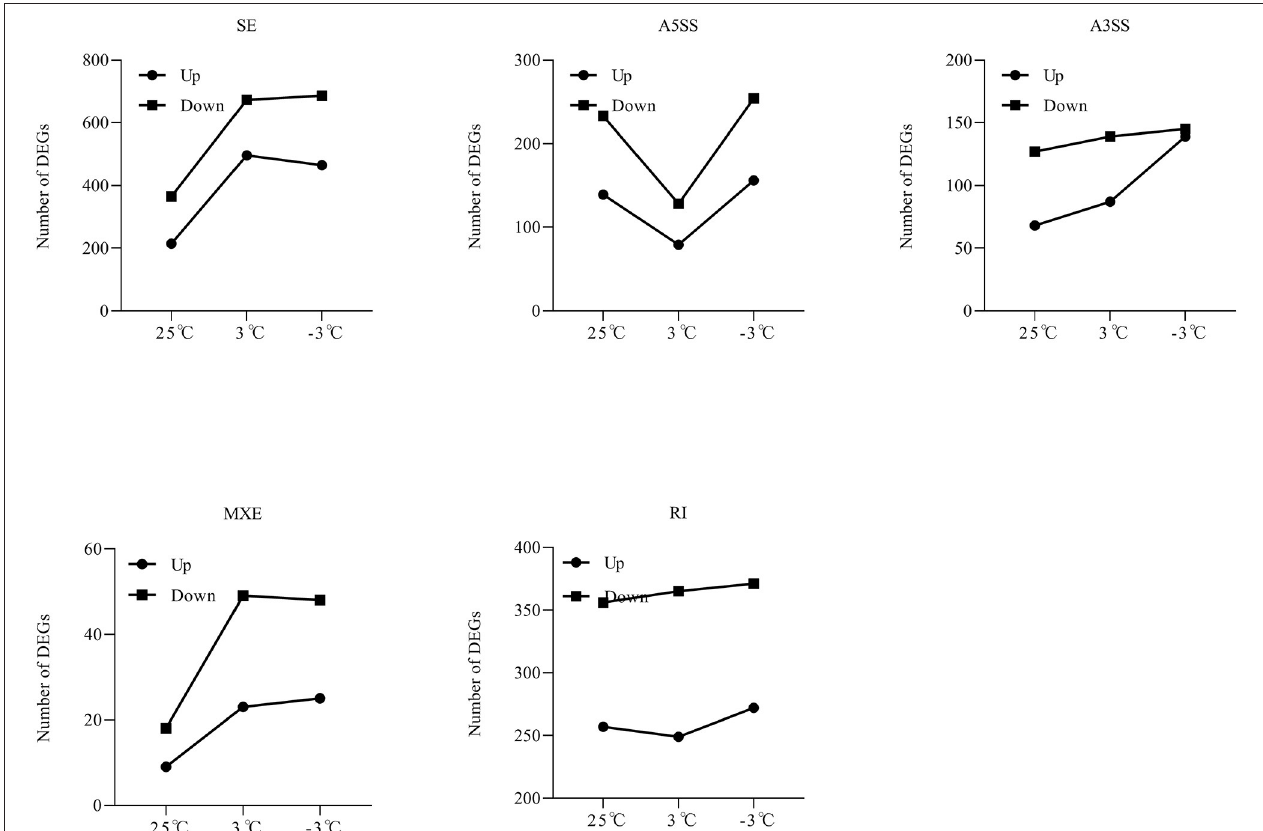
FIGURE 8 | The dynamics of AS types under cold stress in P. ussuriensis compared with P. trichocarpa .